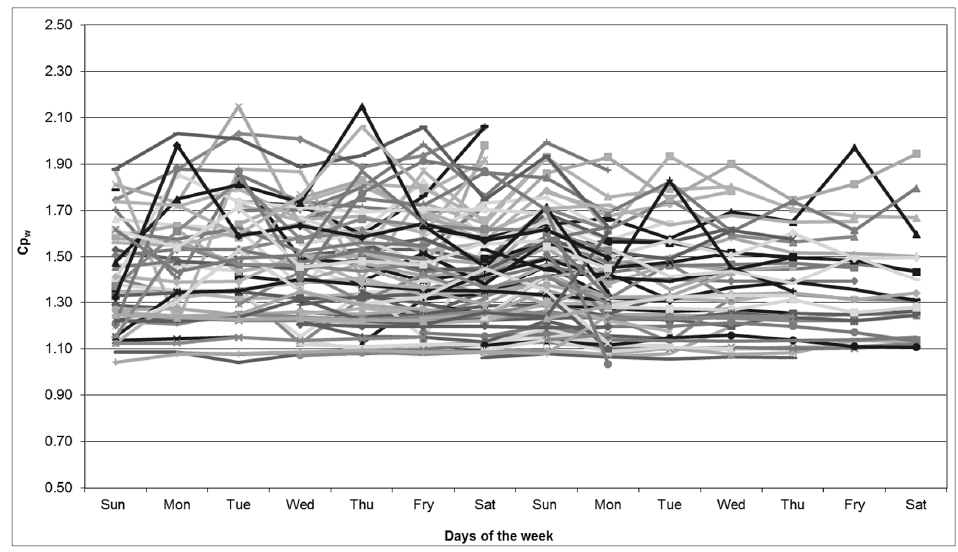
Figure 5. Weekly peak flow coefficient.